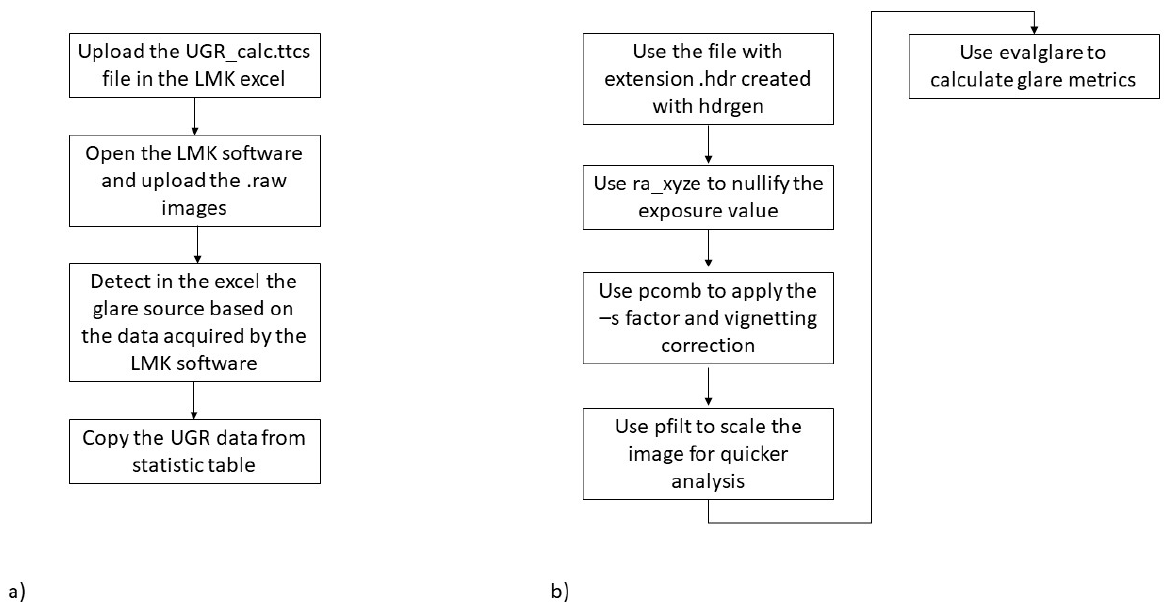
Figure 12. Flowchart calculates UGR: ( a ) professional system; ( b ) low-cost